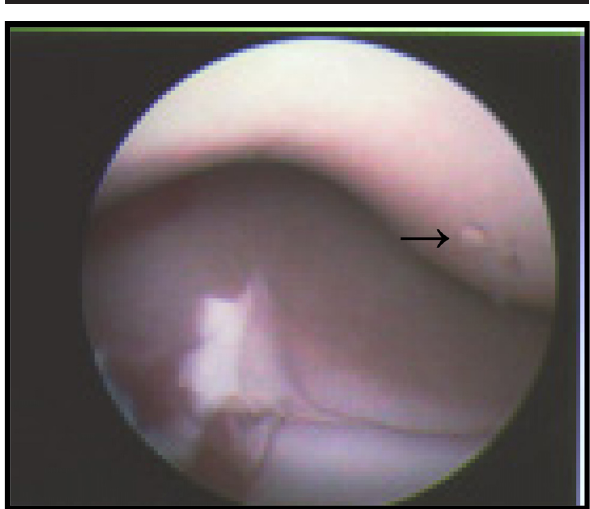
FIGURE 3 - Arthroscopic view of the superficial cartilage → iatrogenic lesion ( ) on capitulum in elbow dog cadaver